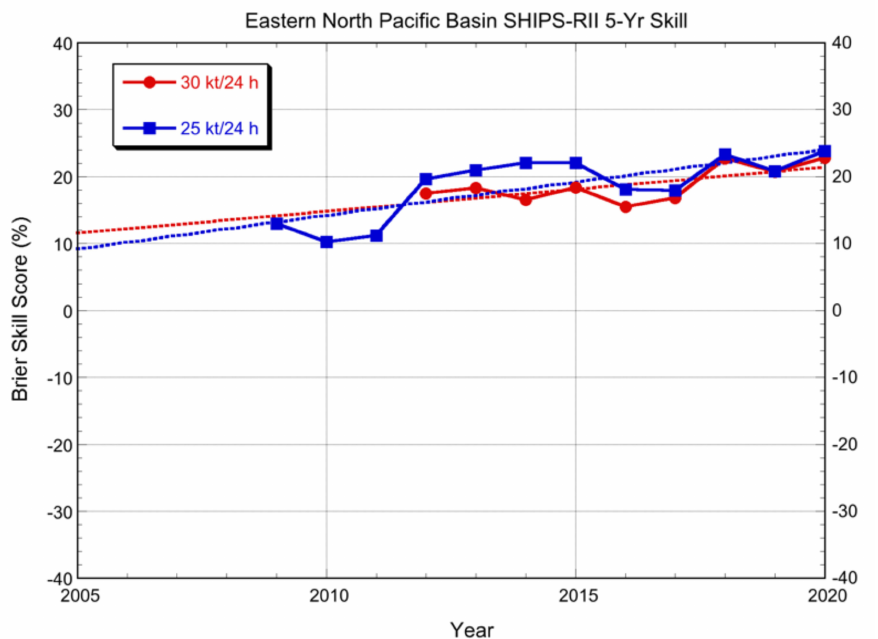
Figure 7. Brier skill score (%) of eastern North Pacific basin SHIPS-RII forecasts for two RI thresholds (30 kt/24 h and 25 kt/24 h). Each point on the diagram represents a 5-yr sample of forecasts, ending at the year indicated. Linear best-fit lines are given by the dashed lines.